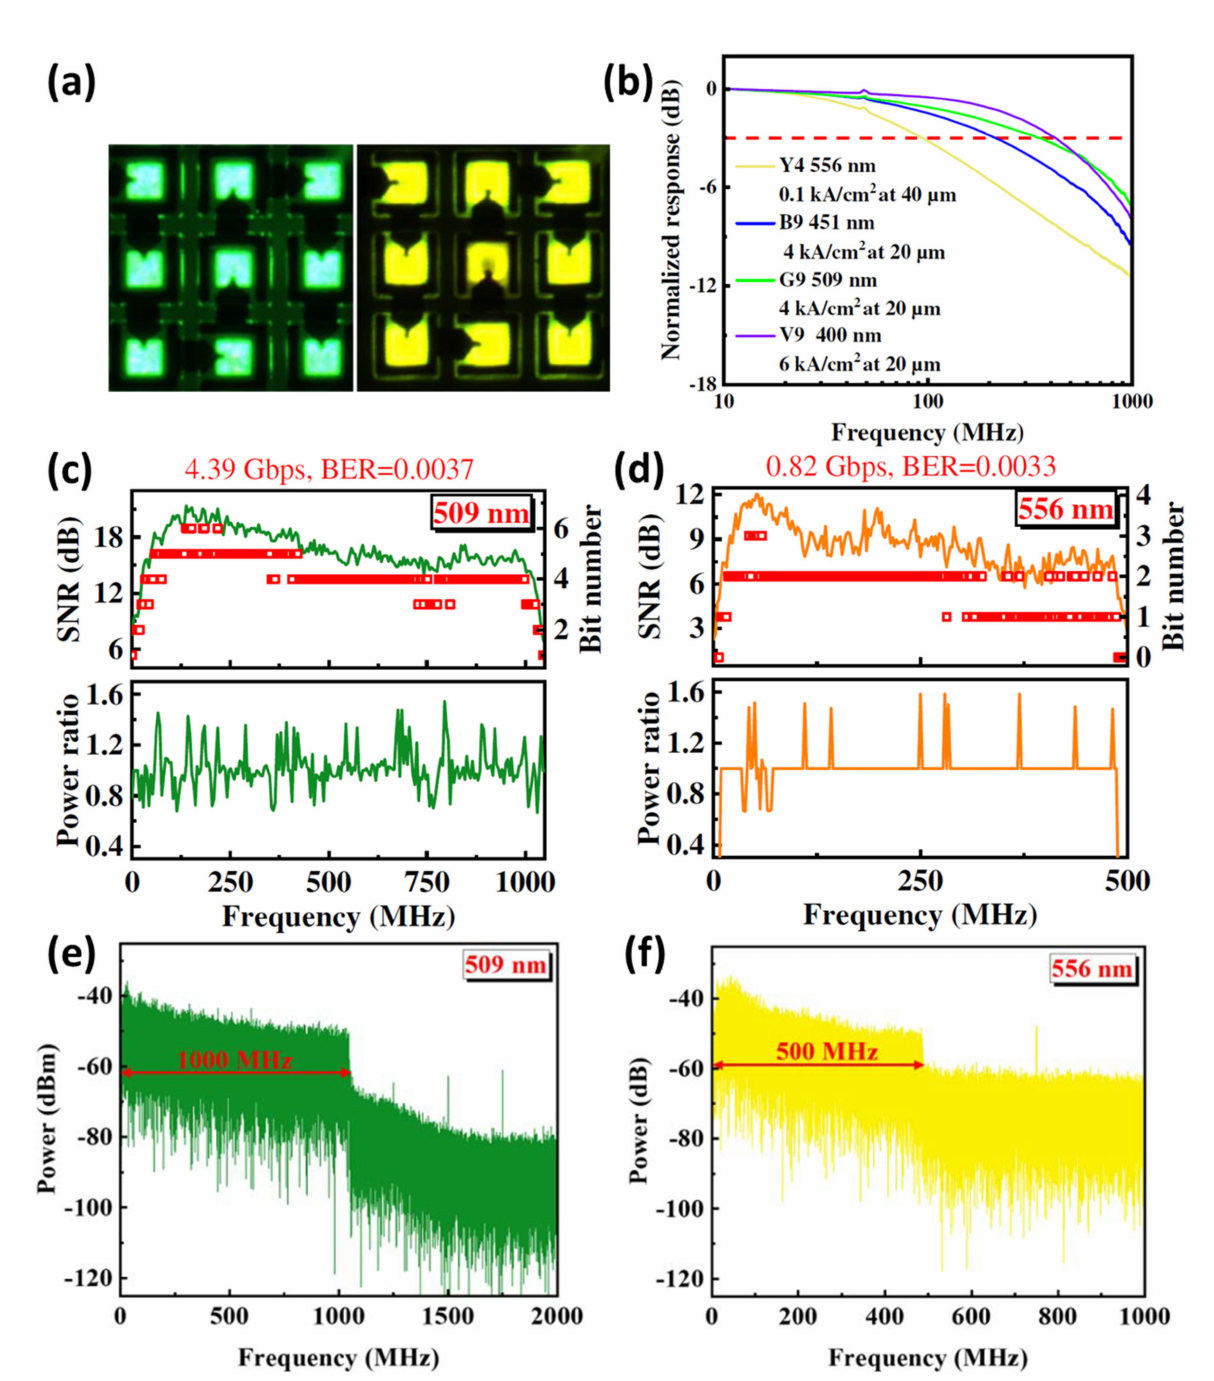
Figure 6. ( a ) Optical micrographs for the green and yellow micro-LED arrays. ( b ) Modulation bandwidths of the micro-LED arrays. ( c , d ) SNR and bit number ( e , f ) Power spectra for the green and yellow micro-LED arrays, respectively. Ref. [15] Figures reproduced with permission from Optica Publishing